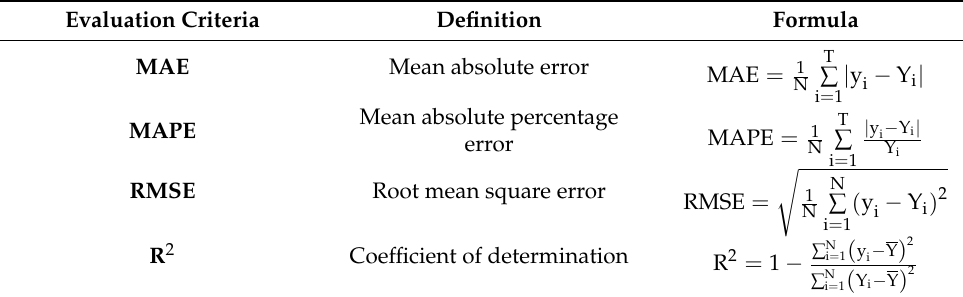
Table 2. Model evaluation criteria 1